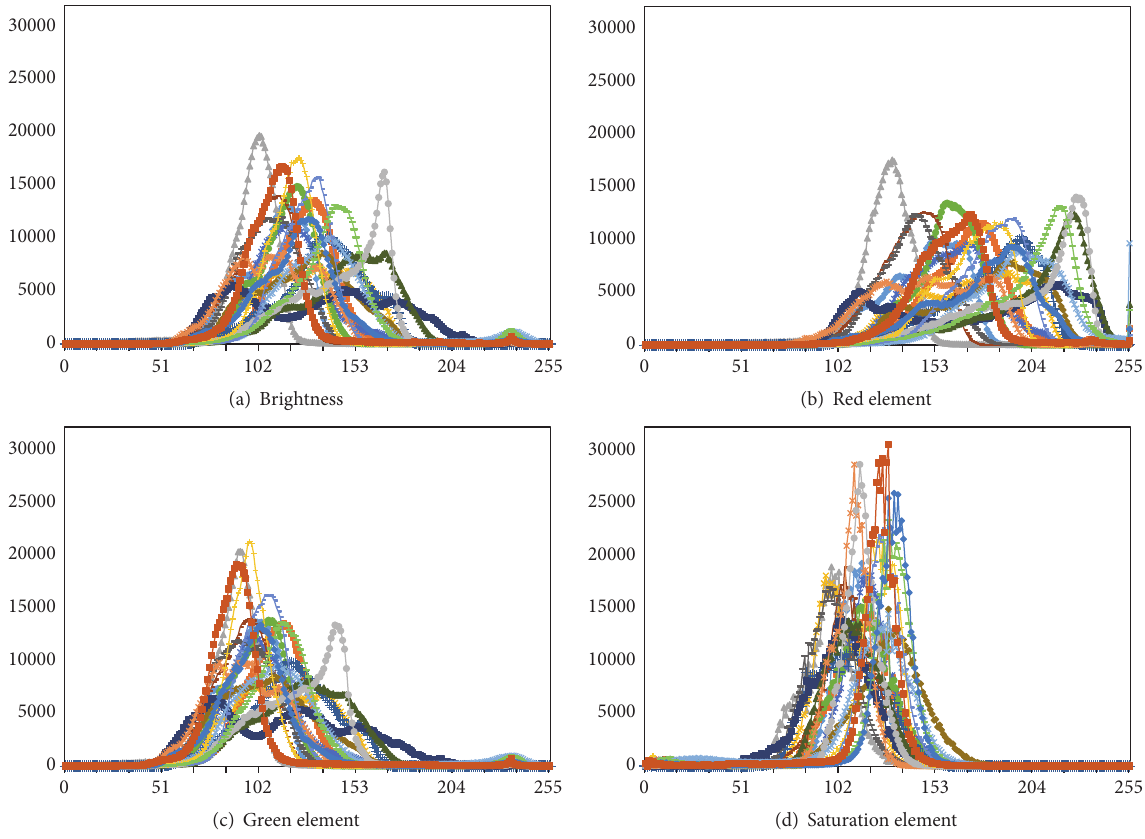
Figure 2: Histograms of the color